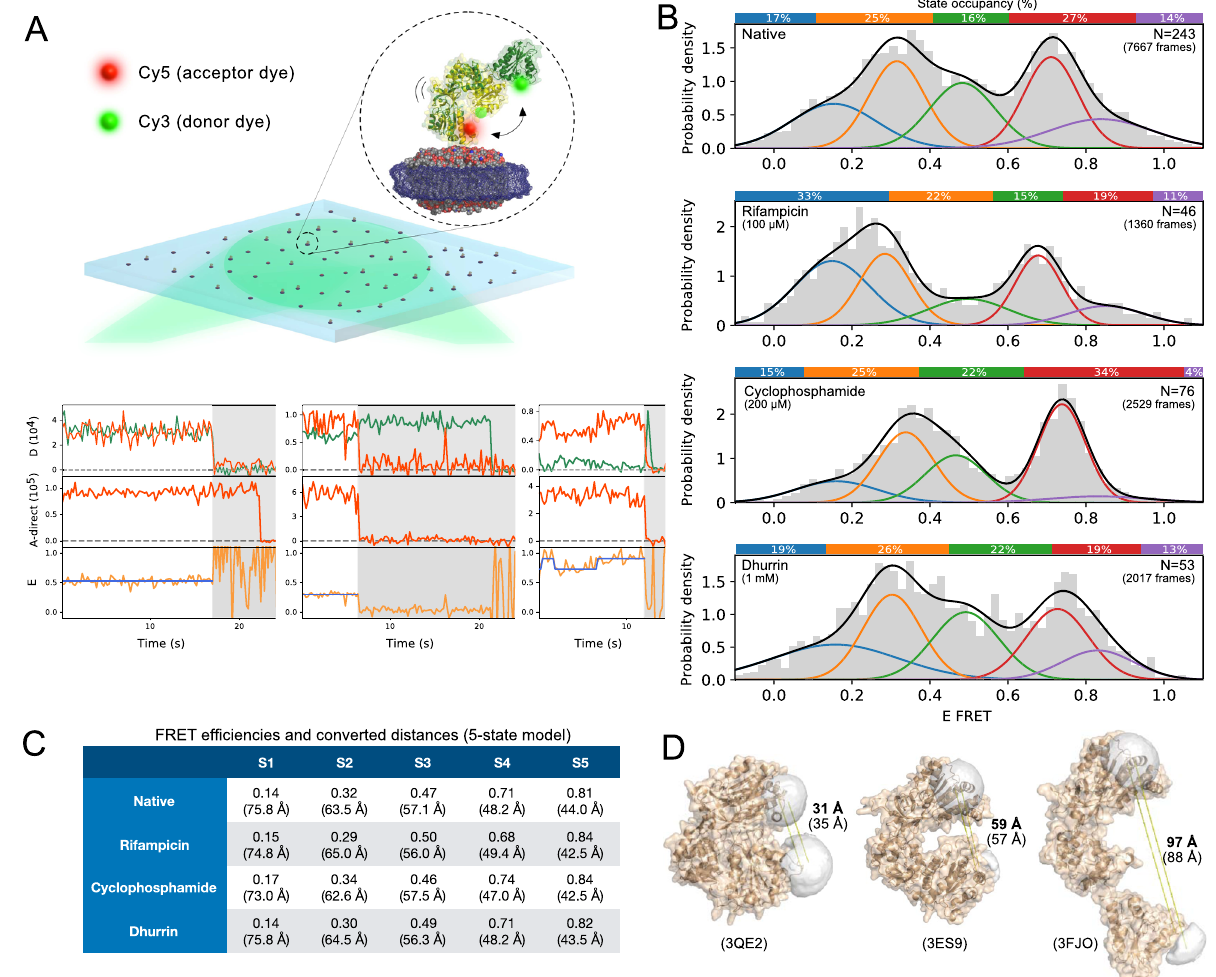
Fig. 4 Direct observation of POR biased conformational sampling by small-molecule ligands using smFRET. A Illustration of smFRET assay using TIRF microscopy. Top; SbPOR2b is site-speci fi cally labeled with Cy3/Cy5 fl uorophores, reconstituted in lipid nanodiscs and tethered on a passivated microscope surface. Bottom; representative smFRET traces displaying FRET states and dynamic transitions between them (see Supplementary Fig. 12 for more examples). Top row: Donor (green) and acceptor (red) intensities over time (s). Middle row: acceptor only intensity (red), bottom row: E FRET values (orange) calculated with calibration factors, and idealized FRET value determined from HMM fi tting (blue). B Distribution of FRET ef fi ciencies in the absence and presence of ligands. Distributions are optimally fi t with 5 states for all conditions as determined from BIC (see Supplementary Methods and Supplementary Fig. 13) with average distances ranging from ~40 to ~80 Å. Rifampicin, cyclophosphamide and dhurrin alter the occupancies of each of the fi ve FRET states indicating biased conformational sampling. Colored bars on top of histograms represent occupancies of each state. N denotes of the number of single molecules at each experimental condition. C FRET ef fi ciencies and converted inter-dye distances obtained from fi ve-state gaussian mixture models. Each FRET state may re fl ect an equilibrium between multiple conformations. D Homology modeling of SbPOR2b from crystal structures of POR isoforms in a compact, intermediate conformation and a human-yeast chimera in a fully extended conformation (PDBs: 3QE2, 3ES9 and 3FJO respectively) with Monte Carlo simulated inter-dye distances (bold) and C α -C α distances (brackets). Source data are provided as a Source Data fi